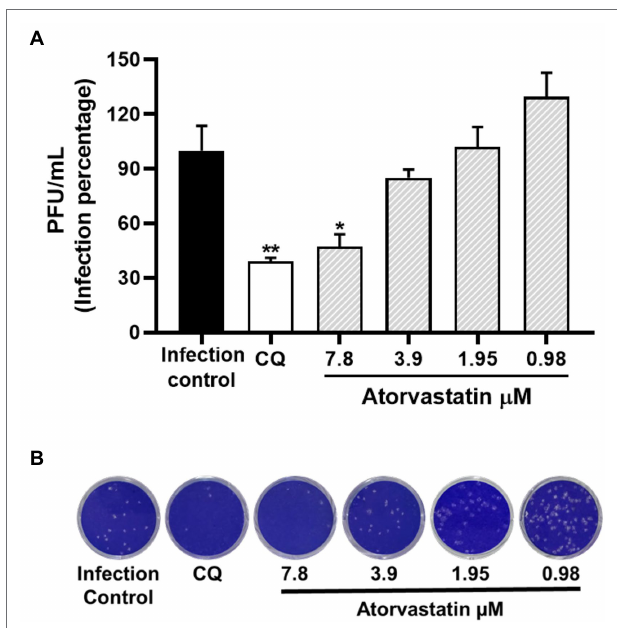
FIGURE 6 | Atorvastatin inhibited SARS-CoV-2 in a human cell line. (A) Reduction of D614G strain titer (PFU/ml) in Caco-2 cells supernatants after pre-post treatment with ATV ( n = 4). (B) Representative plaques of ATV treatment against the SARS-CoV-2 D614G are shown. Chloroquine (CQ) was used as a positive inhibition control. Data were presented as Mean ± SEM. Mann–Whitney test * p ≤ 0.05 and ** p ≤